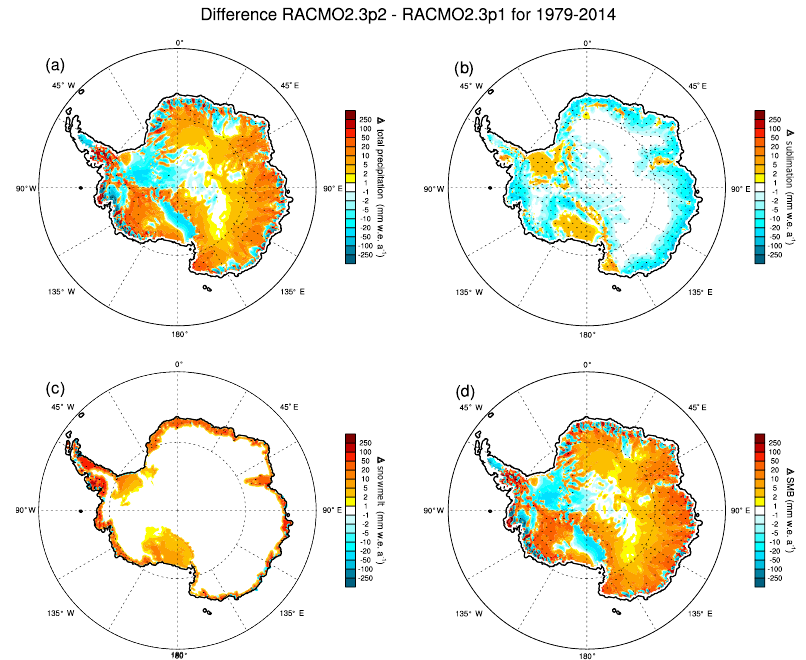
Figure 3. Annual average (1979–2014) difference (RACMO2.3p2–RACMO2.3p1) of (a) total precipitation (snow and rain), (b) total drifting snow and surface sublimation, (c) snowmelt and (d) SMB. Areas where the difference exceeds 1 standard deviation of the difference are